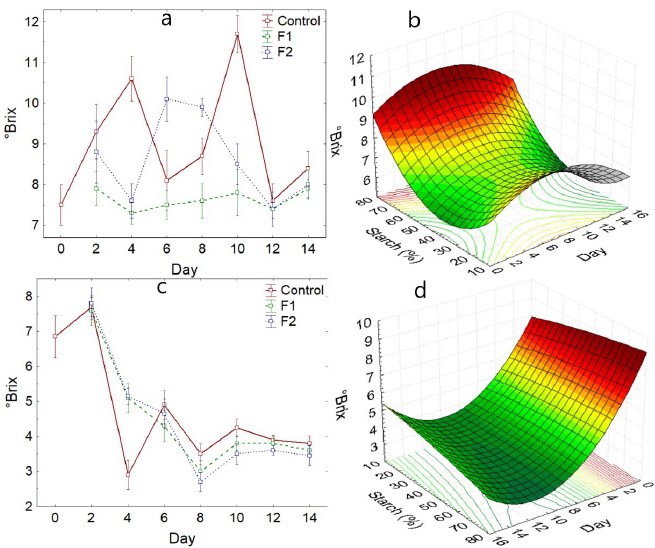
Figure 5. Soluble solids variation, ( a ) Hass variety, ( b ) with respect to the addition of starch—Hass variety, ( c ) Fuerte variety, ( d ) with respect to the addition of starch—Fuerte variety.